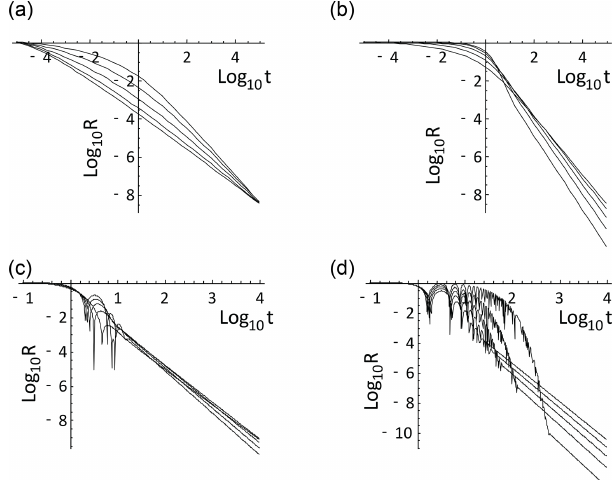
Figure 3. The normalized correlation functions R 0 ,h for fRn cor- responding to the V 0 ,h function in Fig. 4: 0 < h < 1 / 2 (a) , 1 / 2 < h < 1 (b) , 1 < h < 3 / 2 (c) , and 3 / 2 < h < 2 (d) . In each plot, the curves correspond to h increasing from bottom to top in units of 1 / 10 starting from 1 / 20 (a) to 39 / 20 (d) . For h < 1 / 2, the resolu- tion is important since R 0 ,h,τ diverges at small τ . In (a) , R 0 ,h,τ is shown with τ = 10 − 5 ; they were normalized to the value at reso- lution τ = 10 − 5 , and for h > 1 / 2, the curves are normalized with − 1 / 2 F . In all cases, the large t slope is − 1 − h 3